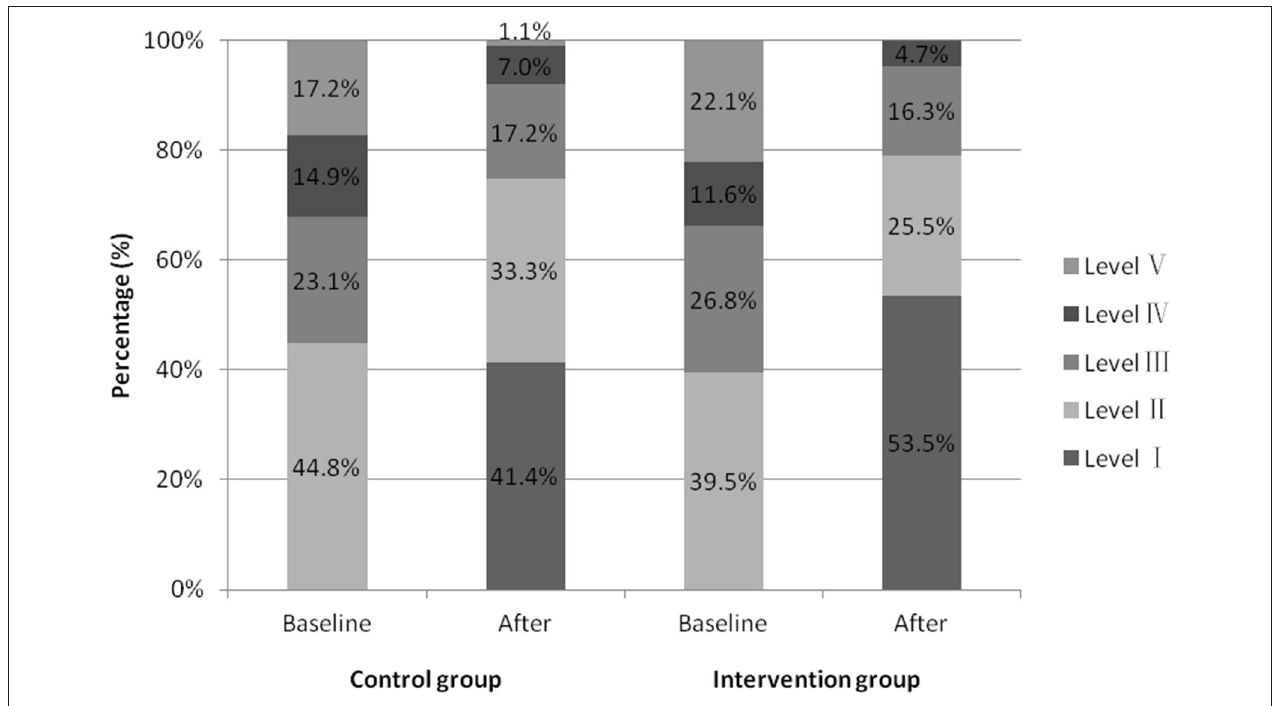
FIGURE 4 | Proportion of water swallow test results before and after seven days of intervention in two